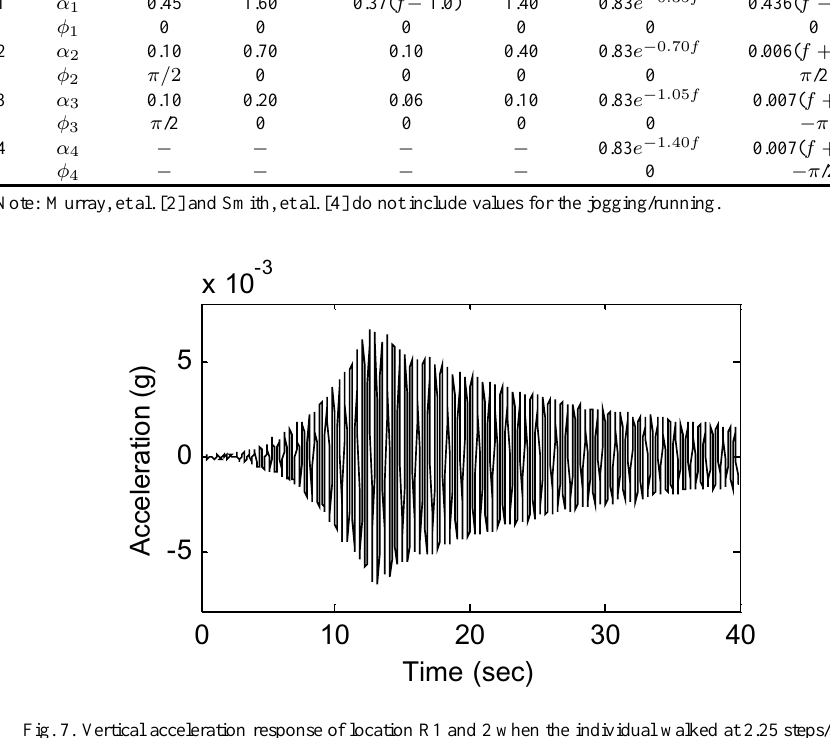
Fig. 7. Vertical acceleration response of location R1 and 2 when the individual walked at 2.25